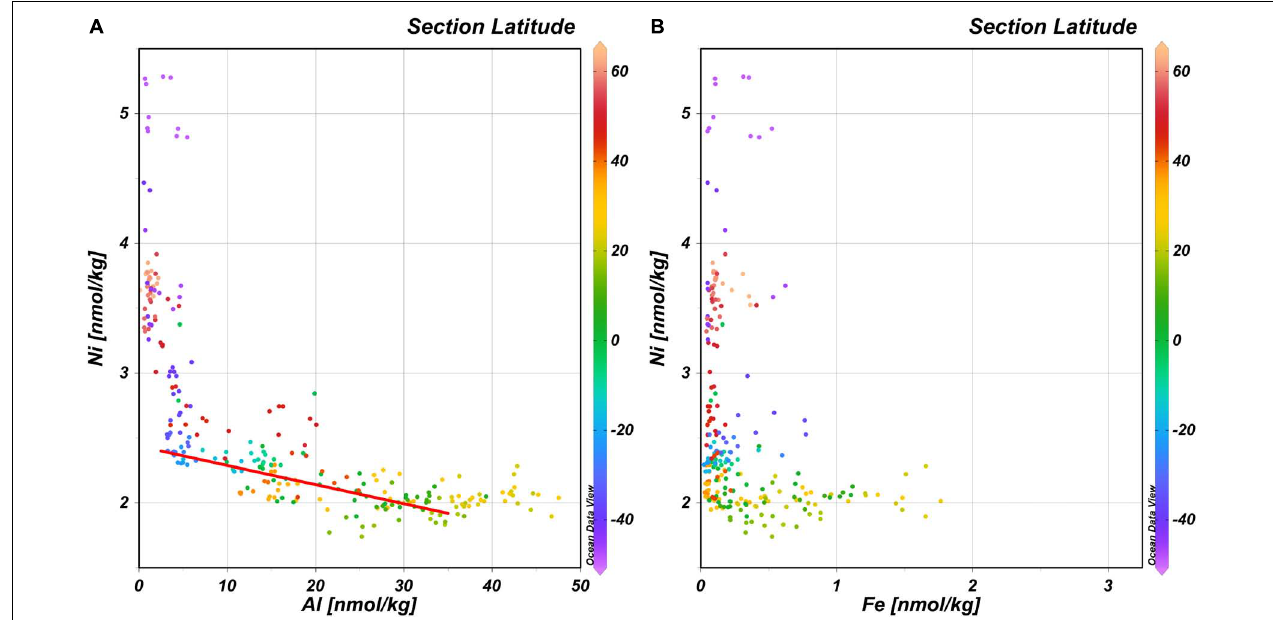
FIGURE 3 | Concentration of Ni versus the concentration of Al and Fe with latitude in color scale. (A) Concentration of Ni versus the concentration of Al in the upper 100 m. Red line gives the regression between 40 ◦ N and 35 ◦ S for Al < 35 nmol/kg; Ni = –0.015 × Al + 2.44. (B) Concentration of Ni versus the concentration of Fe in the upper 100